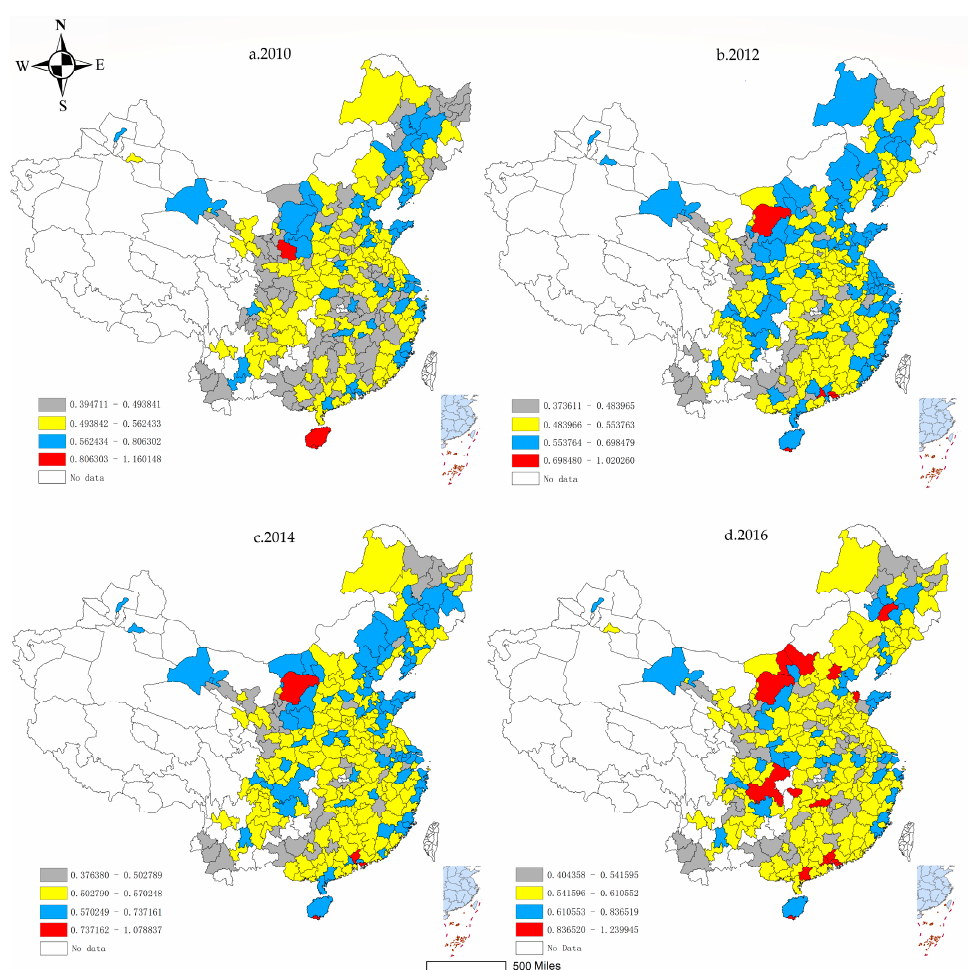
Figure 4. Spatial distribution of ULUE in China. ( a – d ) are spatial distribution maps of ULUE in 2010, 2012, 2014, and 2016.